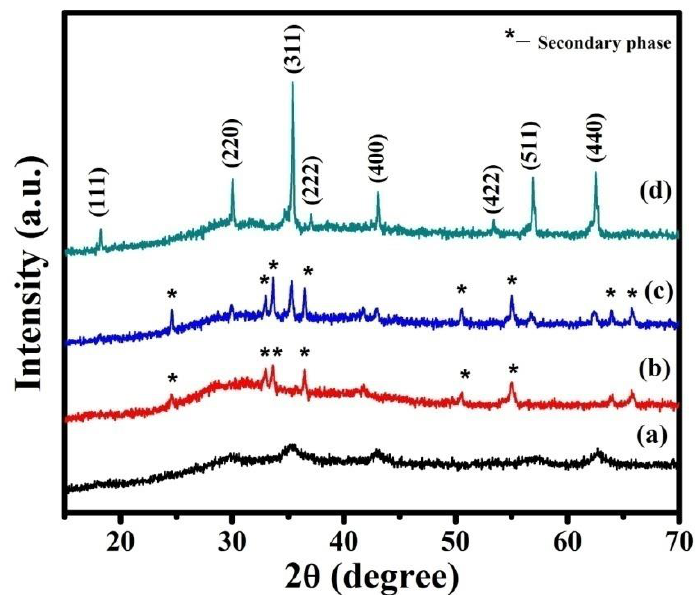
Figure 1. XRD patterns of the samples: ( a ) as-prepared NiMn 2 O 4 (NMO) powder, ( b ) calcined at 600 ◦ C ( c ) calcined at 700 ◦ C, and ( d ) calcined at 800 ◦